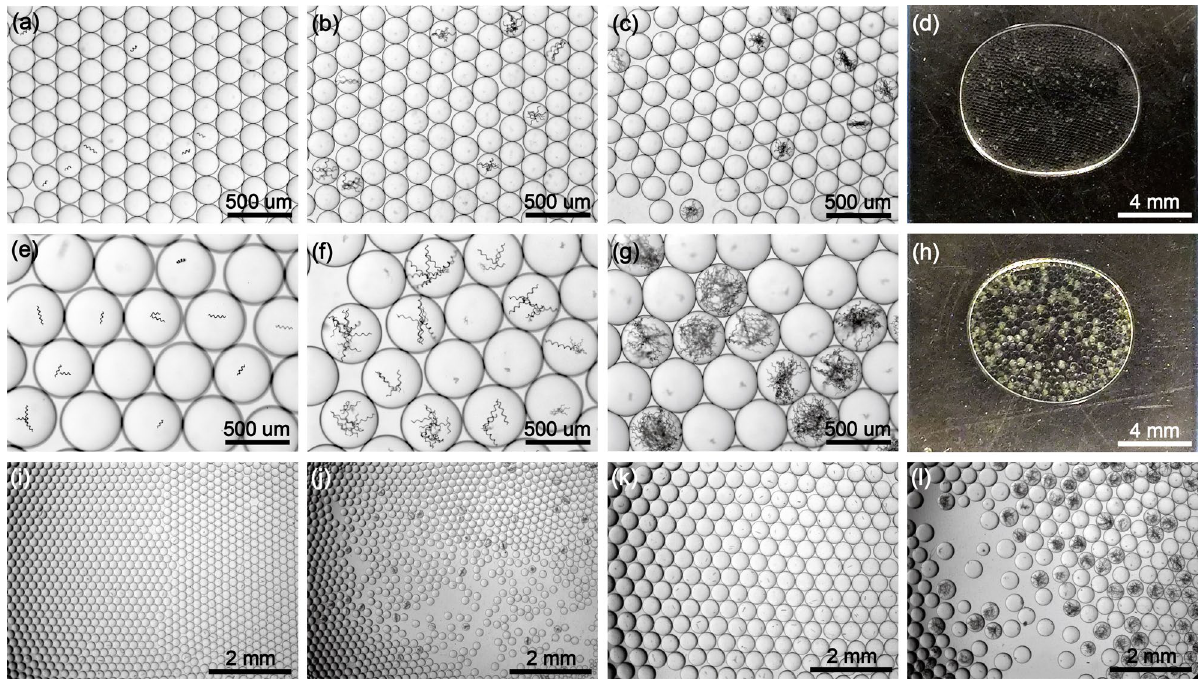
Figure 9. Photosynthetic culturing of spirulina in small ( a – d ) and large ( e – h ) microdroplets inside tape-based imaging chips: ( a , e ) spirulina in as-generated droplets; ( b , f ) proliferated spirulina in positive droplets after 5 days of culturing; ( c , g ) proliferated spirulina in positive droplets after 10 days of culturing; ( d , h ) smartphone imaging of the 10-days culturing droplets showing recognizable color/turbidity differences of positive droplets with spirulina especially in large microdroplets; ( i – l ) low magnification images corresponding to ( a , c , e , g )